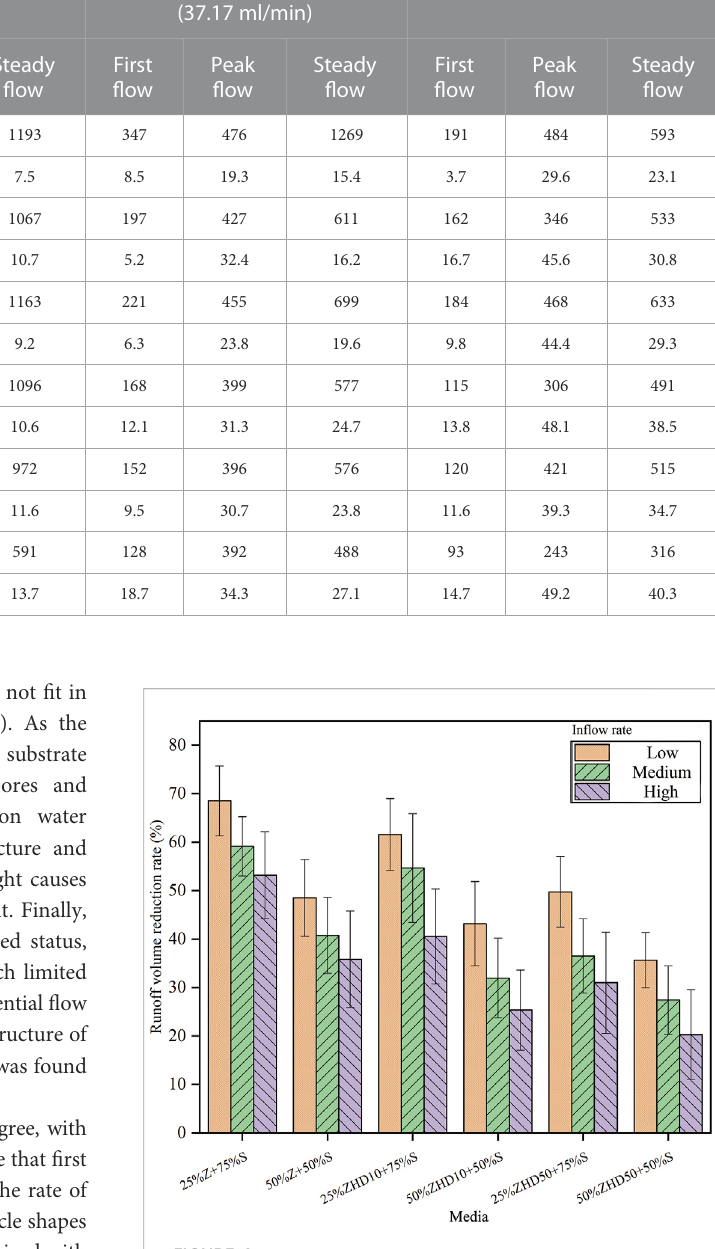
FIGURE 4 Runoff volume reduction rate of different media under different in fl ow